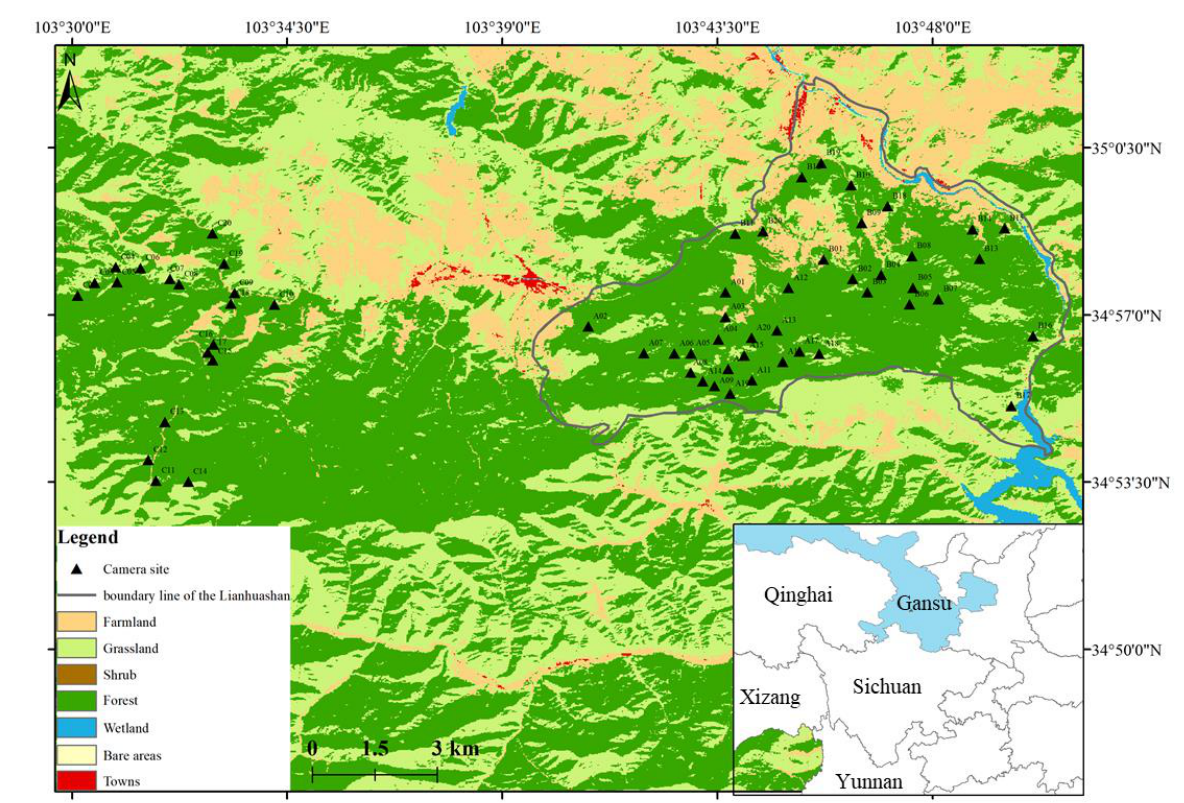
Figure 1. Camera trap locations (black triangles) distributed in the temperate coniferous forests of the eastern Qinghai-Tibet Plateau, China.